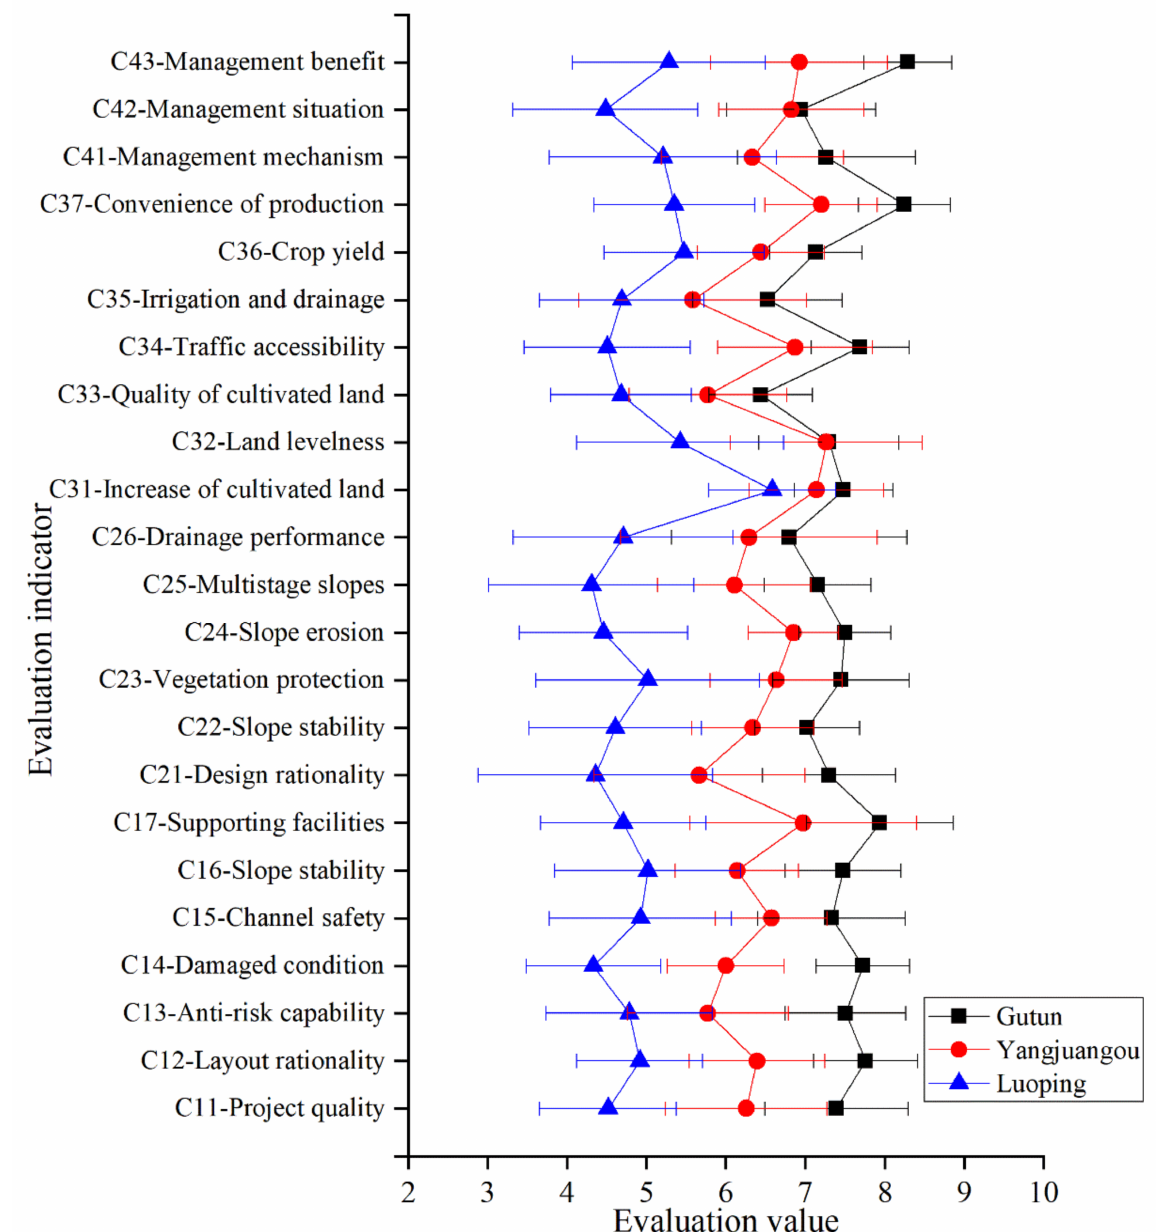
Figure 4. Evaluation value of the secondary indexs of ecological safety effects in different GLCP